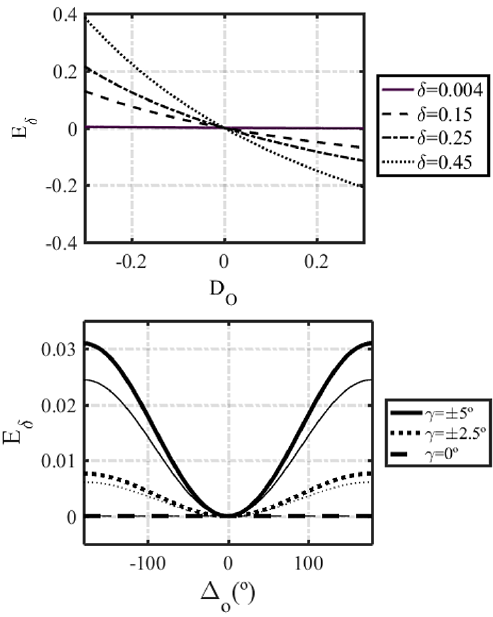
Figure 5. Simulated-to-real δ difference E δ over the diattenuation D O for different δ r values (top) and on the retardance (cid:49) O of the re- ceiving optics for different misalignment angles γ (bottom). Thick and thin lines correspond to δ r values of 0.004 and 0.45, respec-